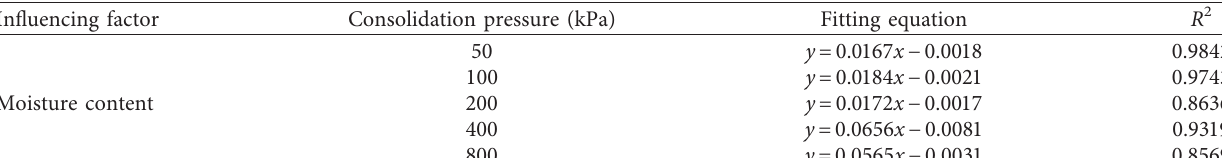
Figure 7: Relationship between moisture content and secondary consolidation coefficient: (a) the result of linear fitting; (b) the result of linear interpolation of 800 kN. Table 8: Regression analysis equation under the influence of moisture content.